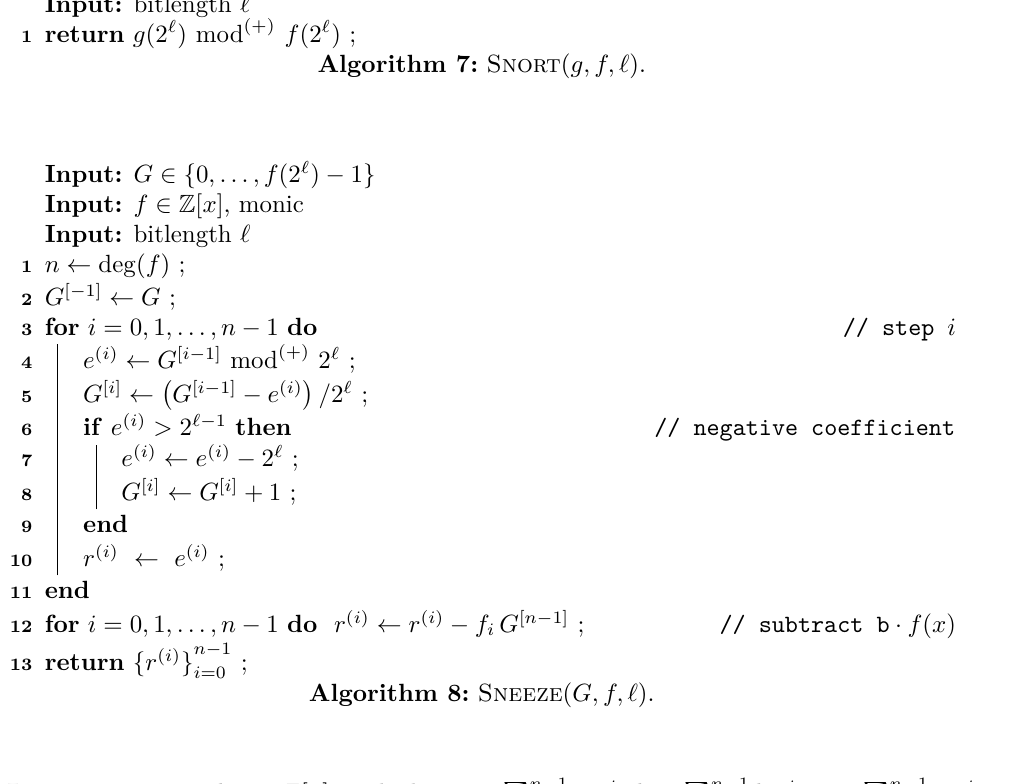
Algorithm 7: Snort ( g, f, ‘ ).